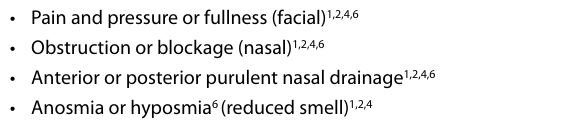
Table I: Important clinical features of chronic